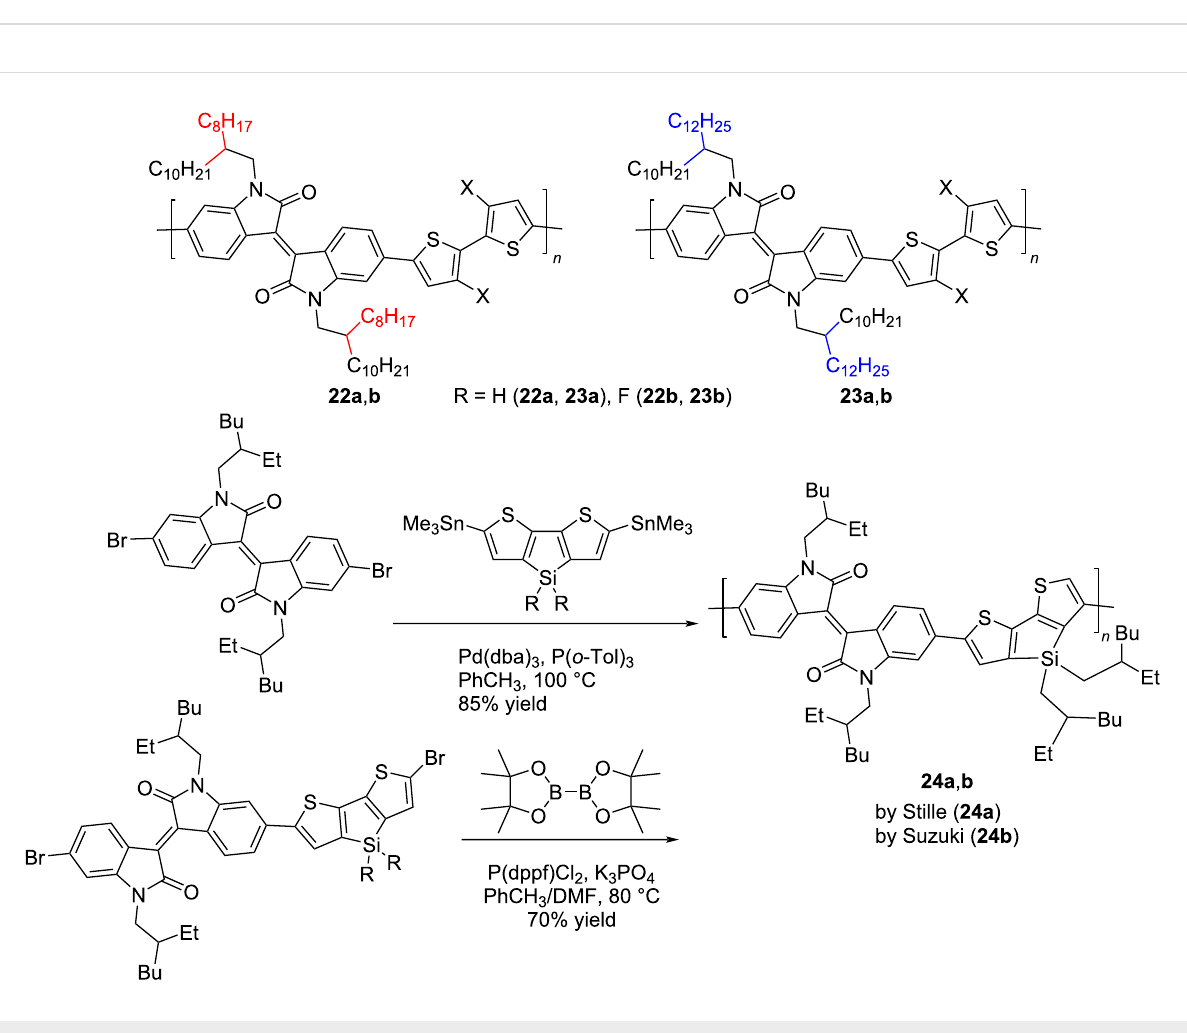
a After annealing at 200